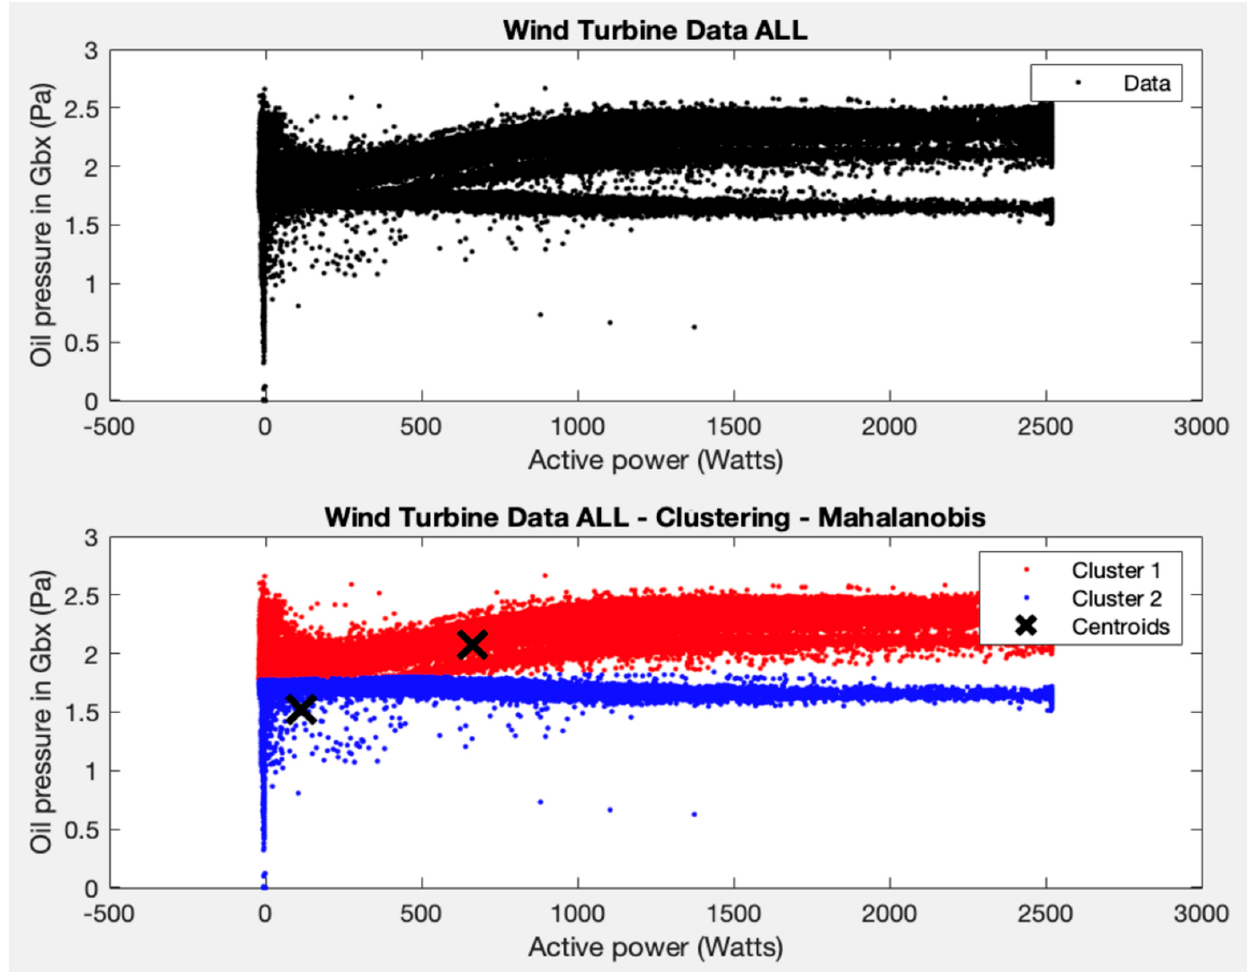
Figure 8. Test 6 results.